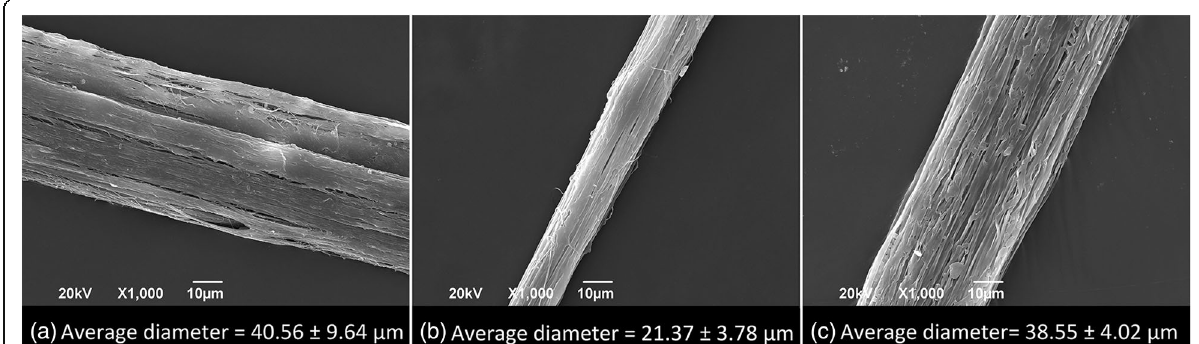
Fig. 5 SEM images of polyamide 6/66 nanofiber bundles obtained through electrospinning sol – gel process at different concentrations. a 12% wt., b 17% wt., and c 22% wt.